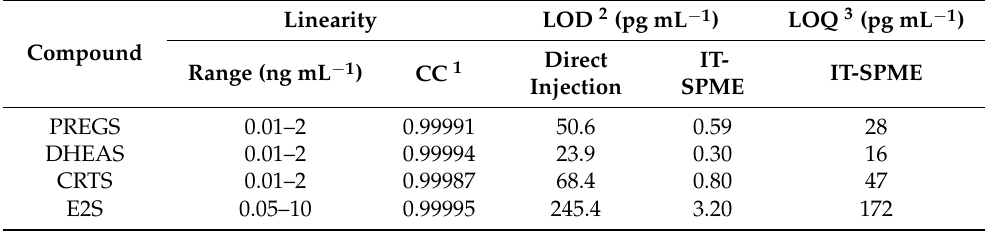
Table 1. Linearity and sensitivity of the IT-SPME LC–MS/MS method for sulfated steroid metabo- lites.